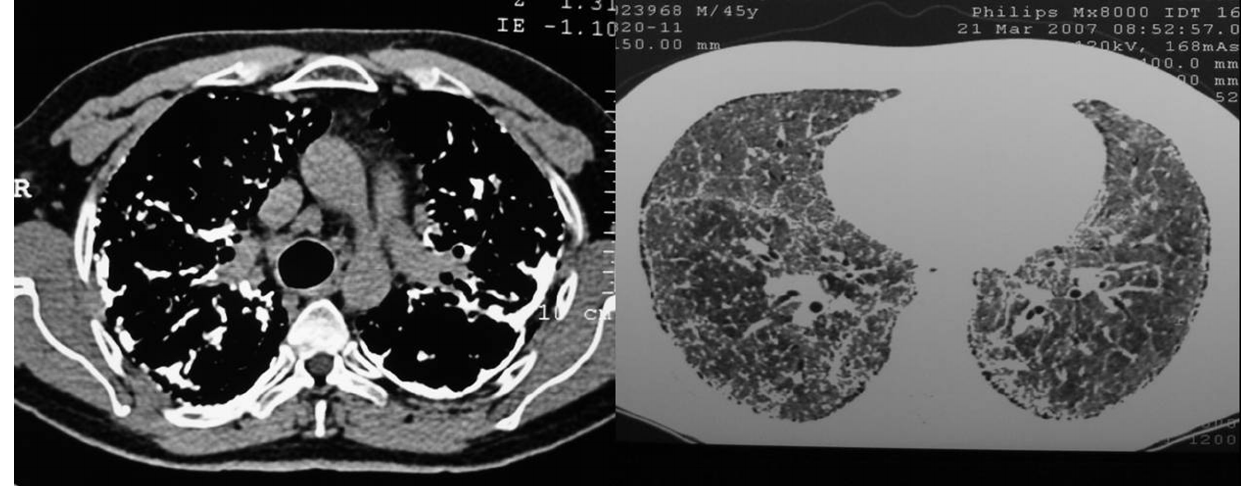
Figure 1 - CT scan showing pleural thickening with calcification and multiples nodules diffusely distributed over the lung parenchyma.